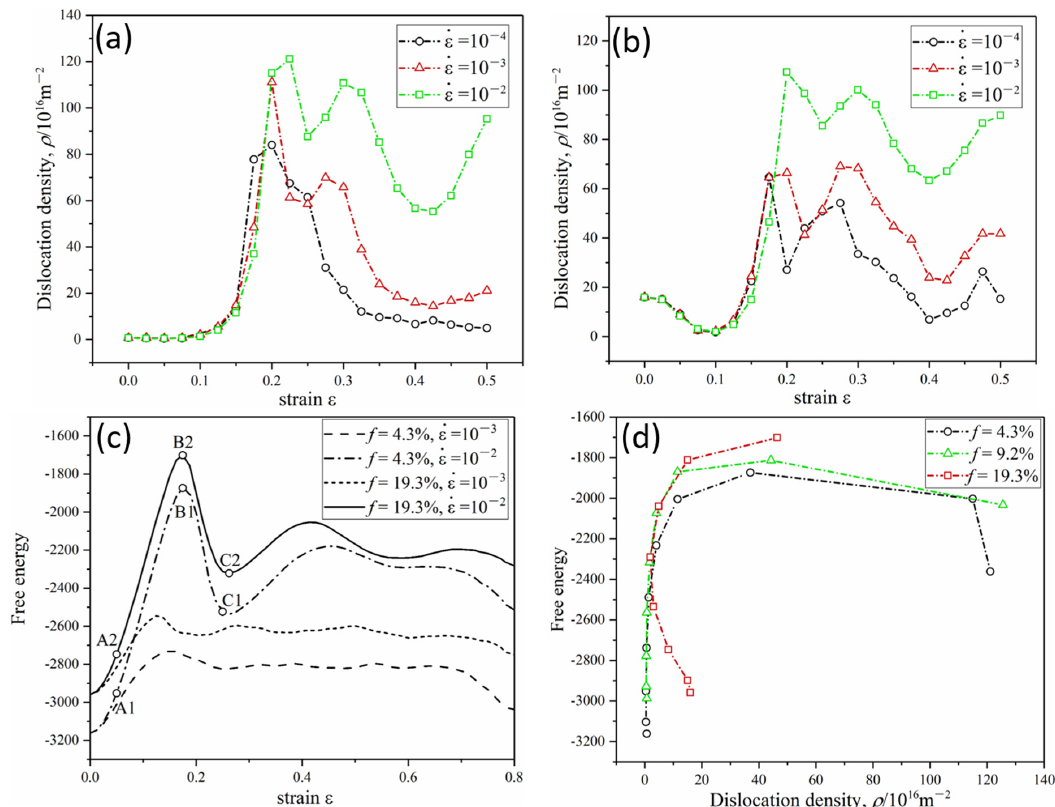
Figure 6. Dislocation density ρ and free energy evolution as a function of deformation strain ε for deformation processes under different degree of lattice misfit f and strain rates 𝜀(cid:4662) . ( a , b ) the ρ ‐ ε curves for lattice misfit f = 4.3% and f = 19.3%, respectively, ( c ) free energy ‐ ε curves for deformation process, ( d ) free energy ‐ dislocation density curves for strain rate 𝜀(cid:4662) (cid:3404) 0.01 . Then, the excessive dislocations would change to decrease the free energy of systems.